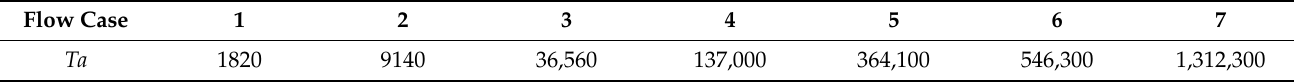
Table 6. The mesh applies same sizing in the outside volume. Since the flow is subjected